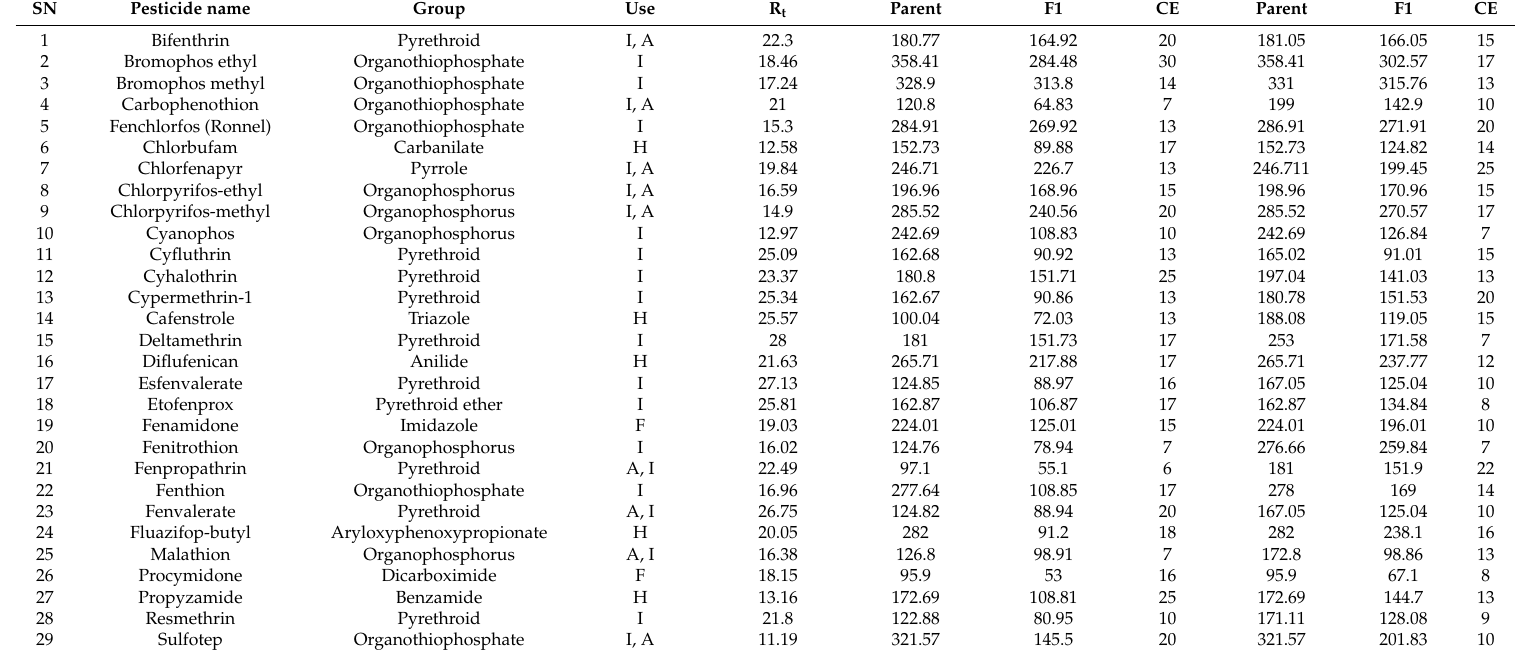
Table 7. Summary of GC-MS / MS pesticides (properties and